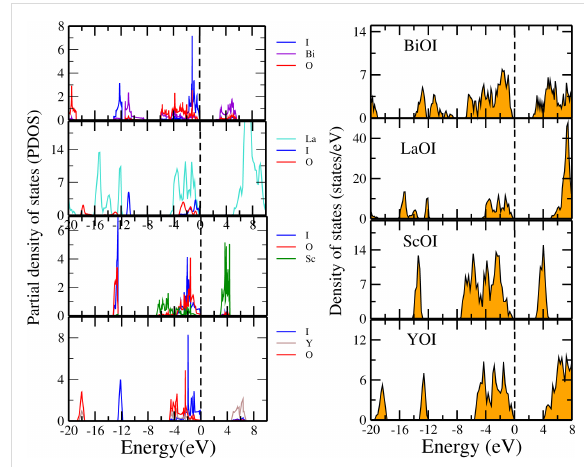
Figure 4: Partial and total density of states of monolayers of AcOCl, AlOCl, BaFCl, and BiOCl. The Fermi level is set to 0 eV.